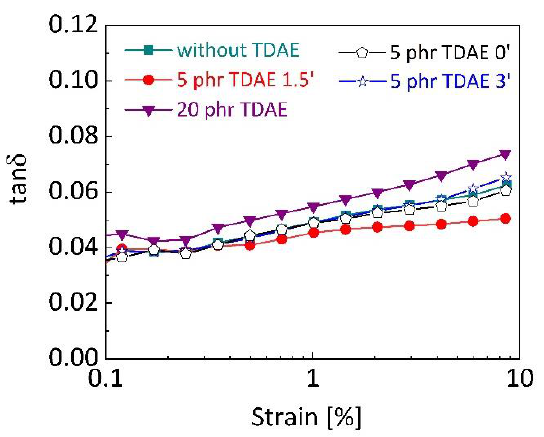
Figure 9. Mechanical loss factor (tan δ ) of silica-filled SBR/BR vulcanizates depending on TDAE content and addition time. The analyses were carried out with 10 Hz frequency and at 60 °C.